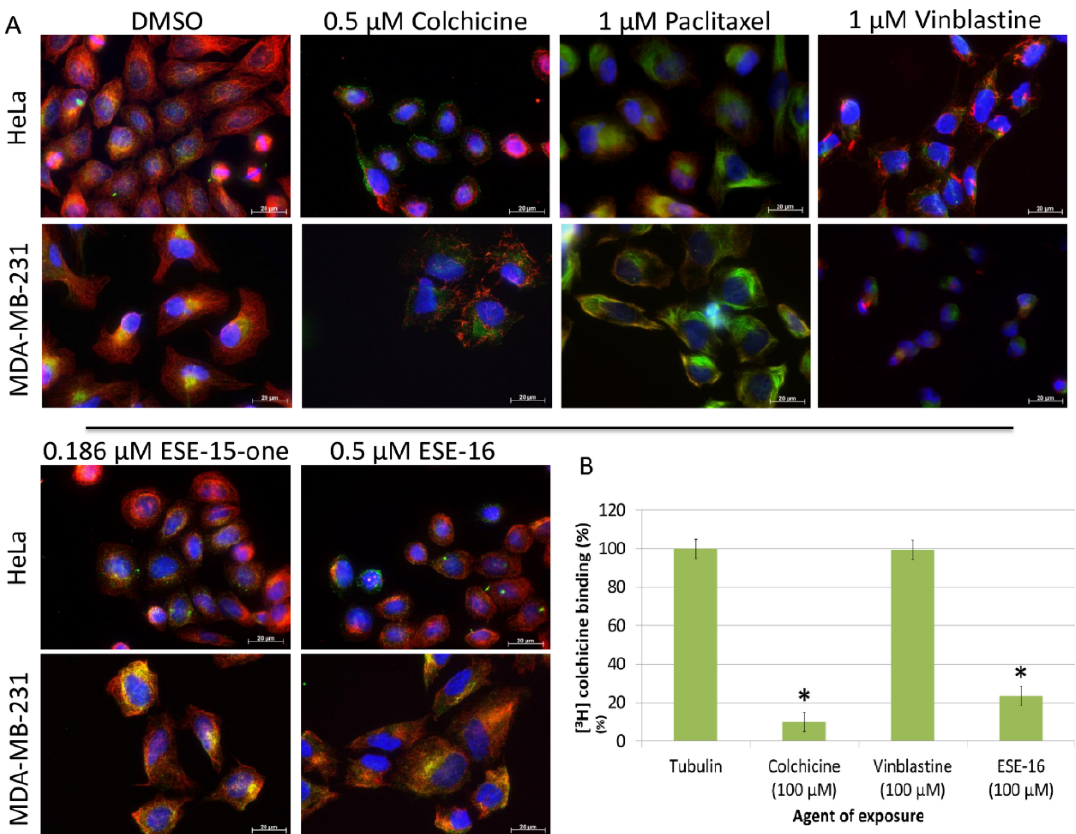
Figure 2. ESE-16 and ESE-15-one affect cellular microtubules by binding to the colchicine-binding site of tubulin. ( A ). Double immunofluorescence of HeLa- and MDA-MB-231 cells exposed to the indicated compounds for 2 h. Dynamic tyrosinated microtubules (MTs) were stained red whereas stable detyrosinated MTs were stained green. Nuclei were counterstained blue with DAPI (63× magnification; scale bar = 20 µm). ( B ). Effect of ESE-16 on the binding of [3H]-colchicine. ESE-16 (100 µM) was used to compete with [3H]-colchicine (50 nM) as described in the methods section. Each value represents the mean ± SEM of 3 independent experiments. Colchicine was used as pos- itive control and vinblastine as negative control. * p < 0.05.